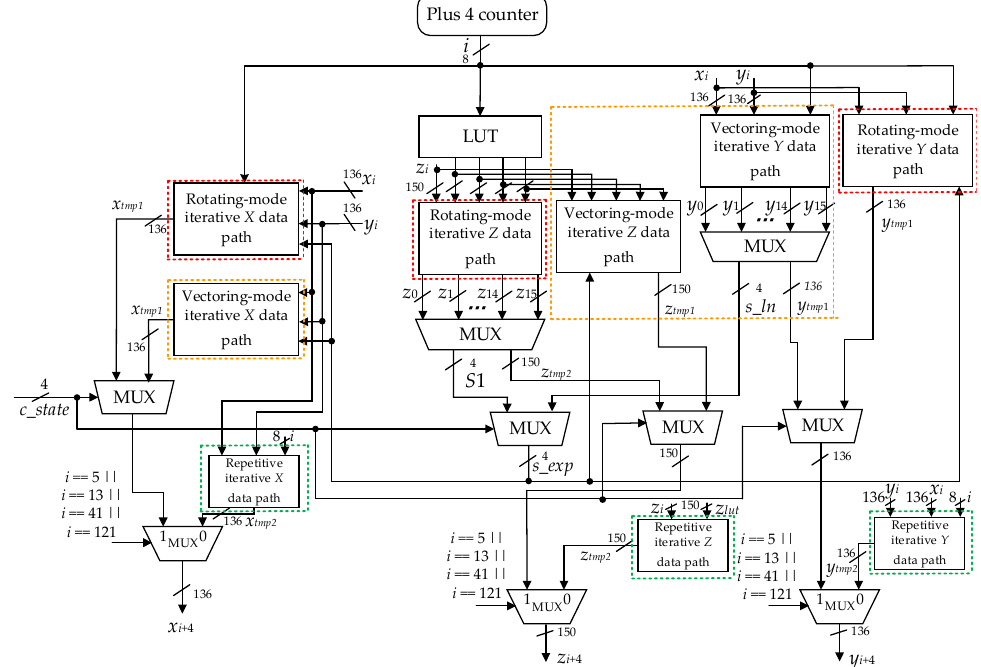
Figure 3. Vectoring mode and rotating mode of QH CORDIC.